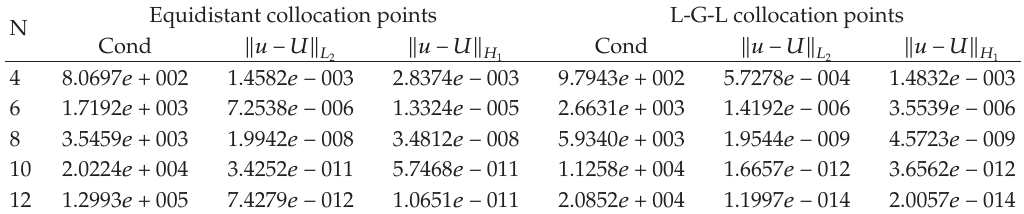
Table 8: Convergence analysis of Example 4.2 by Lagrange collocation method (cid:5) β